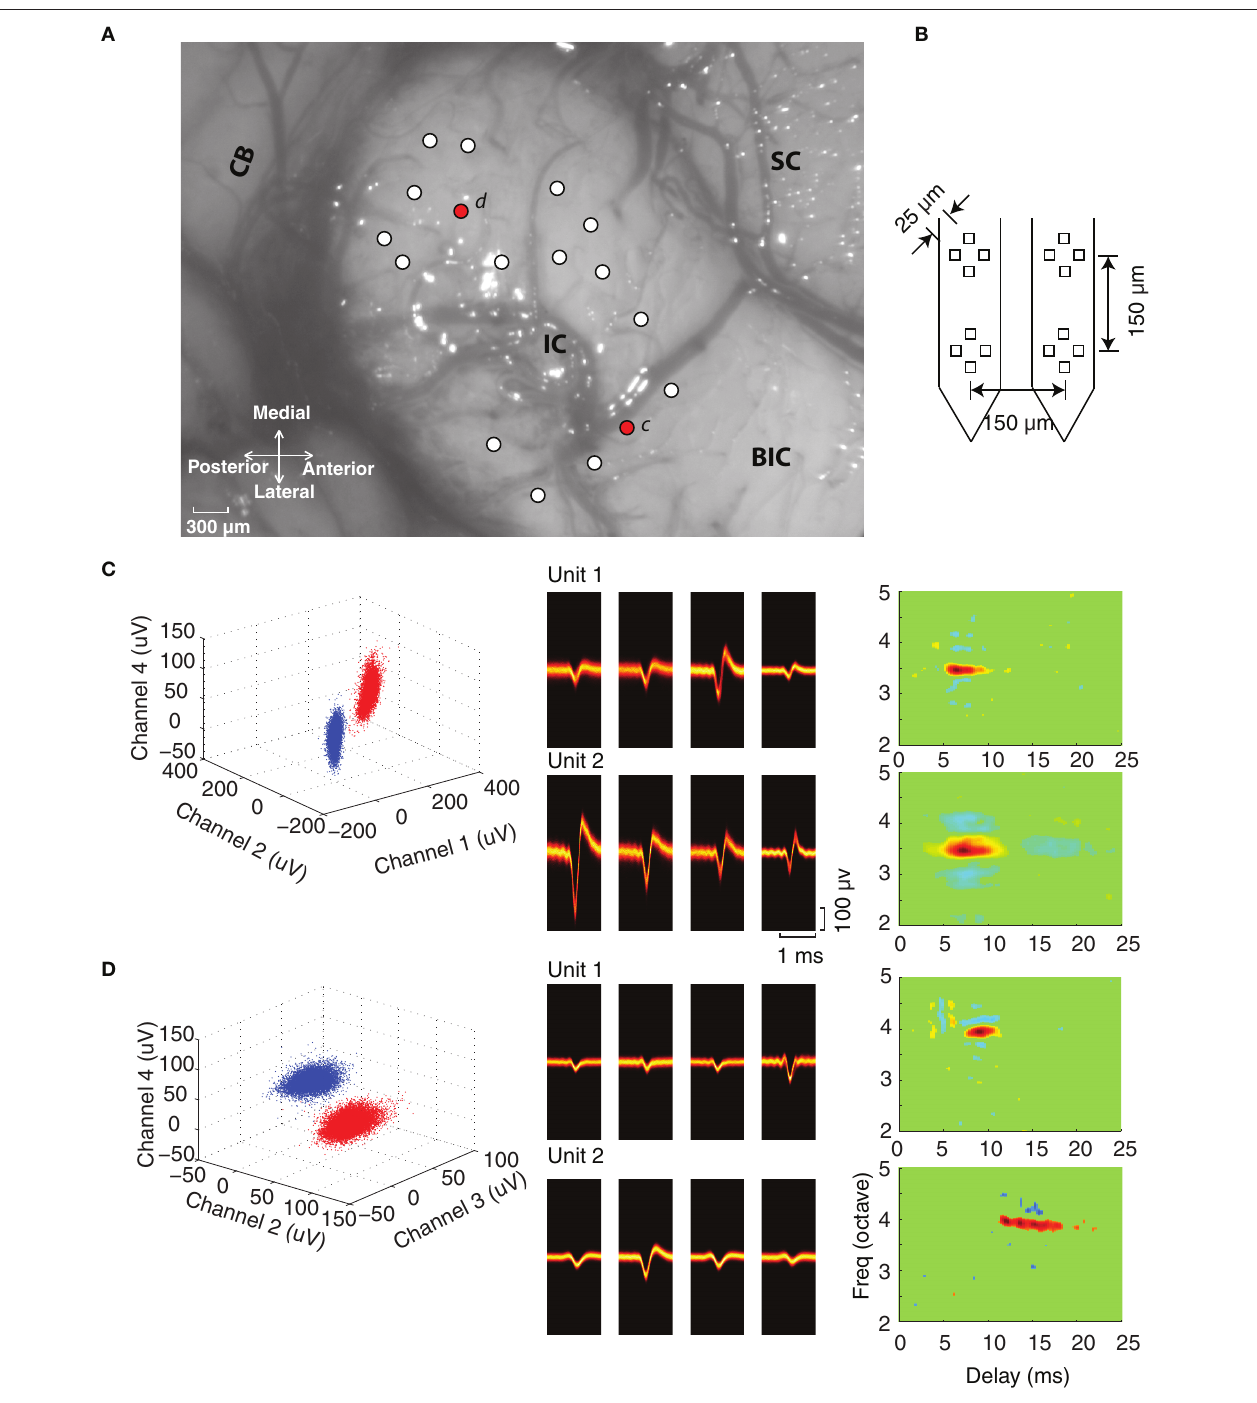
peak waveform amplitudes clusters at selected tetrode channels (blue and red clusters, left ). The spike waveform density plots ( middle ) on each of the tetrode channels are shown for each of the isolated units. The waveform density represents the probability that the action potentials recorded on a given channel follow a particular waveform trajectory (color represents probability; orange is high, black is low), thus highlighting the most likely waveform pattern for each channel. Spectrotemporal receptive fields (STRF) are shown for each of the isolated units on the far right